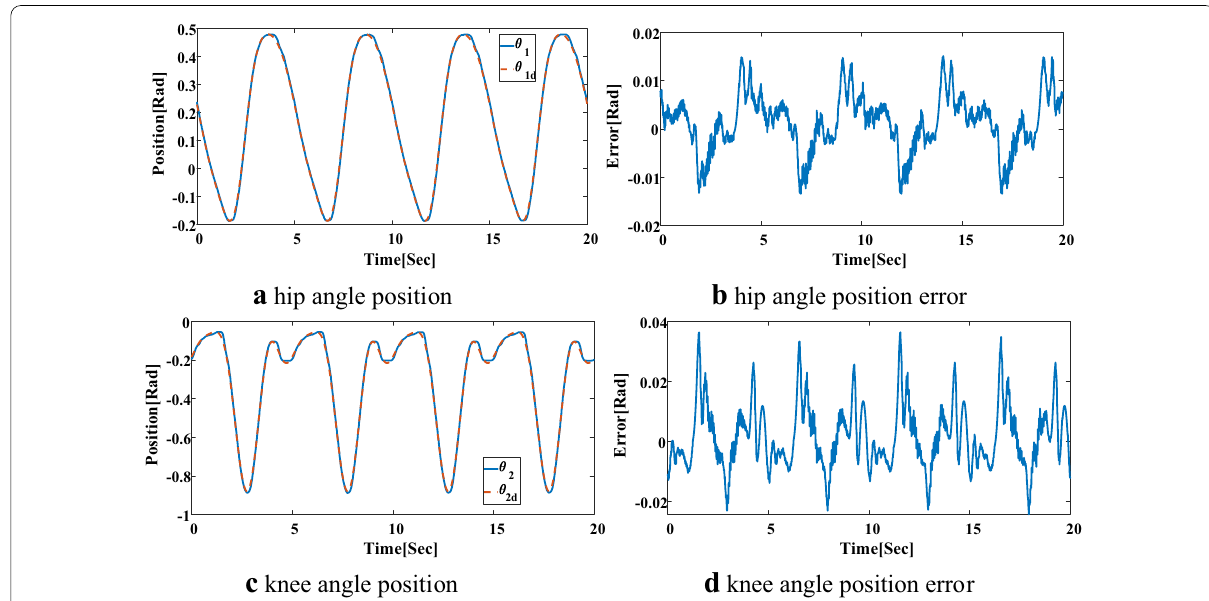
Figure 11 Two joint angle positions and errors by using the backstepping controller in exoskeleton passive mode